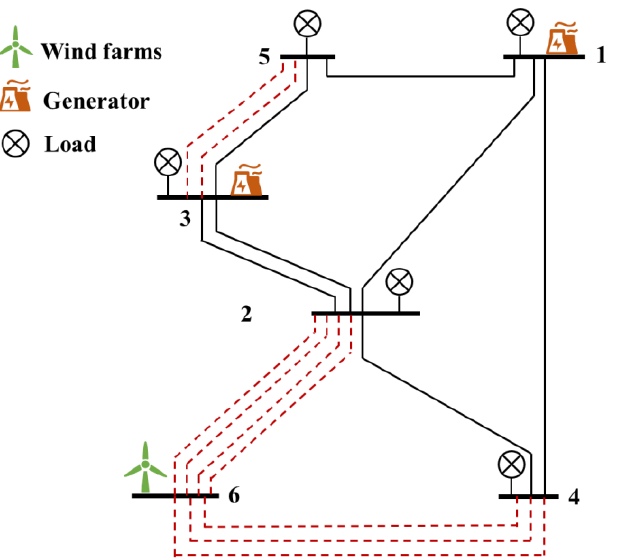
Figure 8. Optimal results for Garver’s 6-bus system.